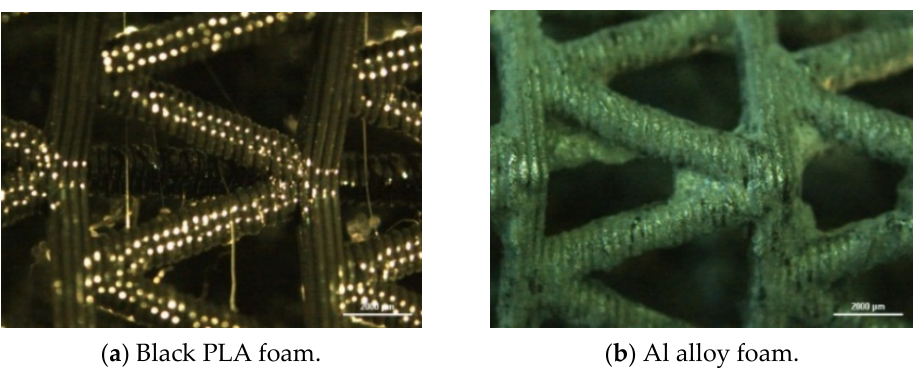
Figure 9. Stereo microscope observations: ( a ) black PLA foam; ( b ) Al alloy foam.